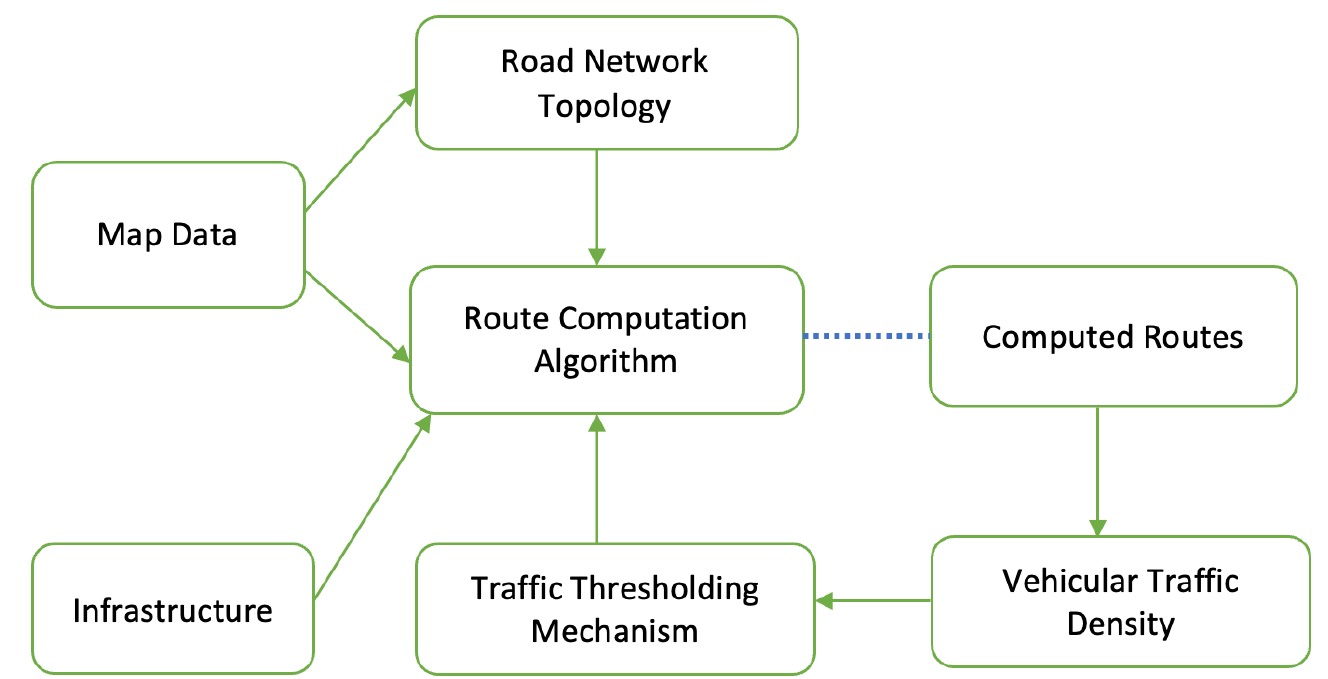
Figure 1. Flowchart of the main concepts employed in the